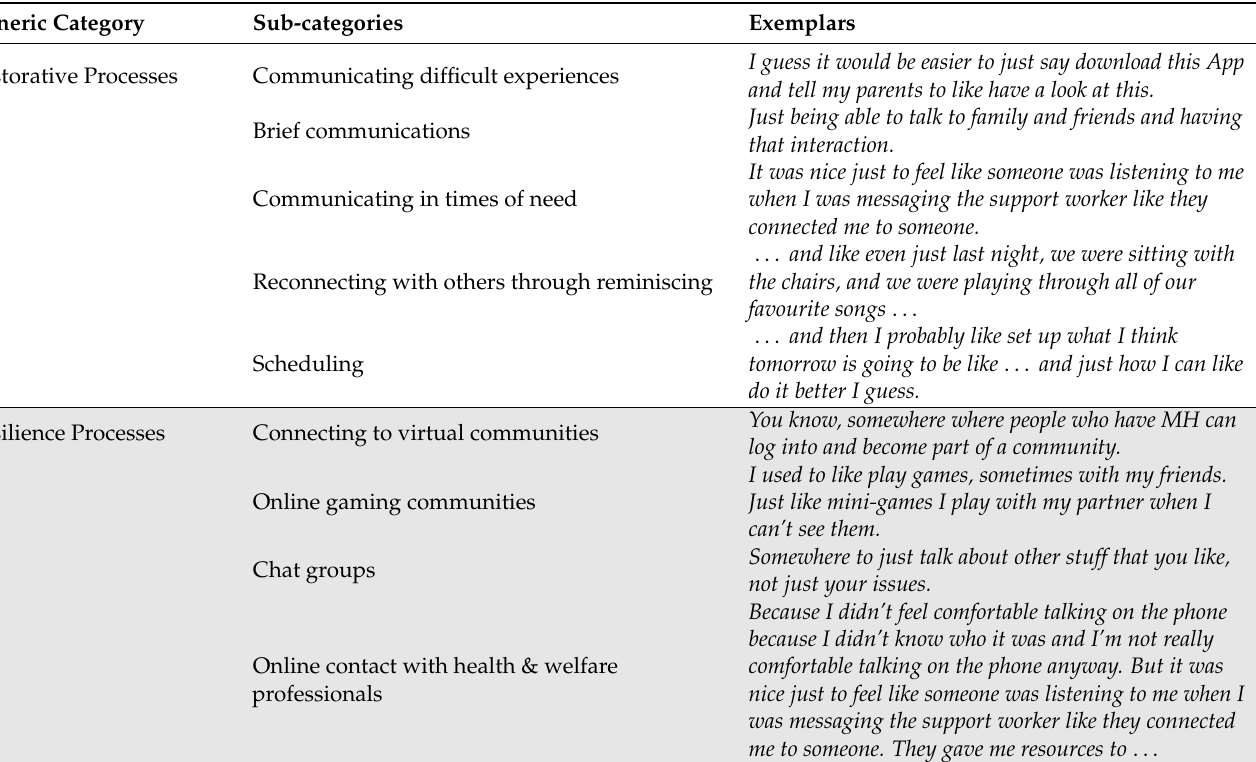
Table 5. Exemplars and categories related to connectedness recovery